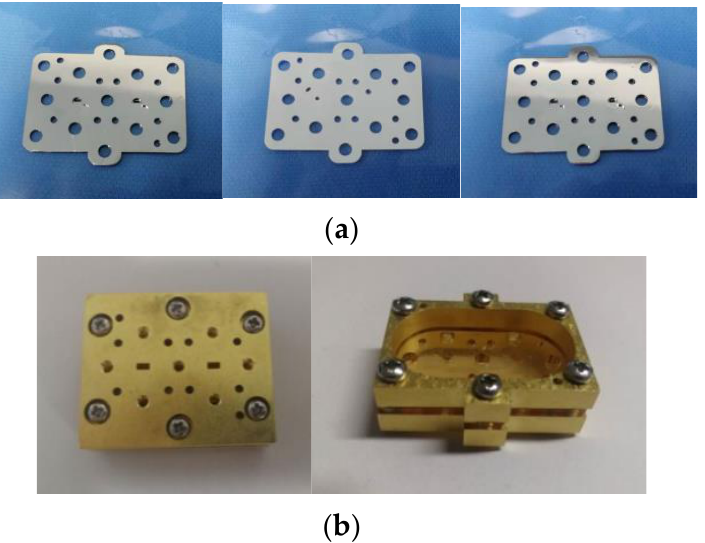
Figure 10. Structure diagram of processing filter. ( a ) Filter composed of 3 layers of SU-8 and ( b ) a picture of the measuring platform with pressure block Ⅰ on the left and with pressure block Ⅱ on the right.